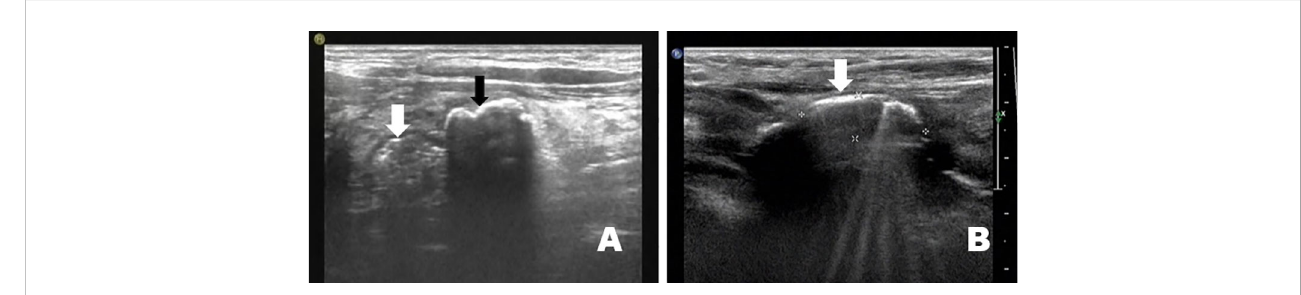
FIGURE 2 PED was found in combination with thyroid nodules in 73.5% (50/68) of cases (A) , image from a 56-year-old man). After thyroidectomy, a PED appeared in the thyroid region (B) , image from a 42-year-old